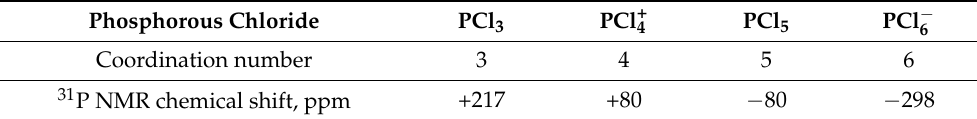
Table 6. Coordination number of phosphorous chlorides and their 31 P NMR chemical shifts. Phosphorous